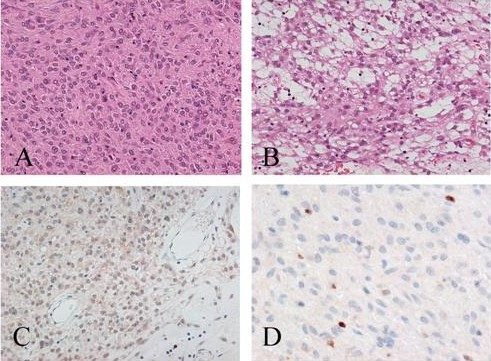
Photomicrographs of the primary omental GIST tumor. A. Epithelioid components of GIST. Tumor cells show eosinophilic cytoplasm and peripherally placed nuclei, and are mostly cohesive (H&E). B. Some components show a spindle cell pattern with myxoid stroma (H&E). C. Tumor cells weakly immunoreactive for c-kit (CD117). D. Immunostaining for MIB-1: sparse of positive tumor cells are shown (MIB-1 index: 4.4%).